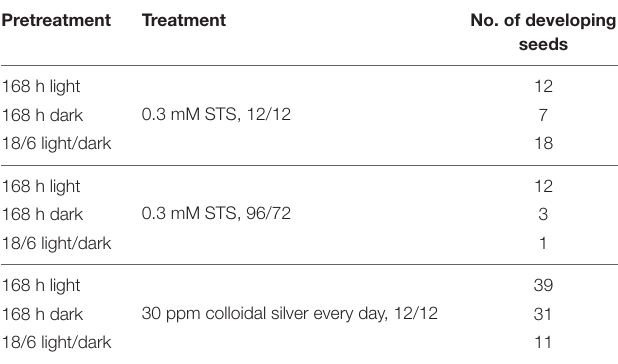
TABLE 6 | Number of developing seeds 2 weeks after pollination with pollen from plants MX-CBD-707 induced with different light (pre)treatments and silver